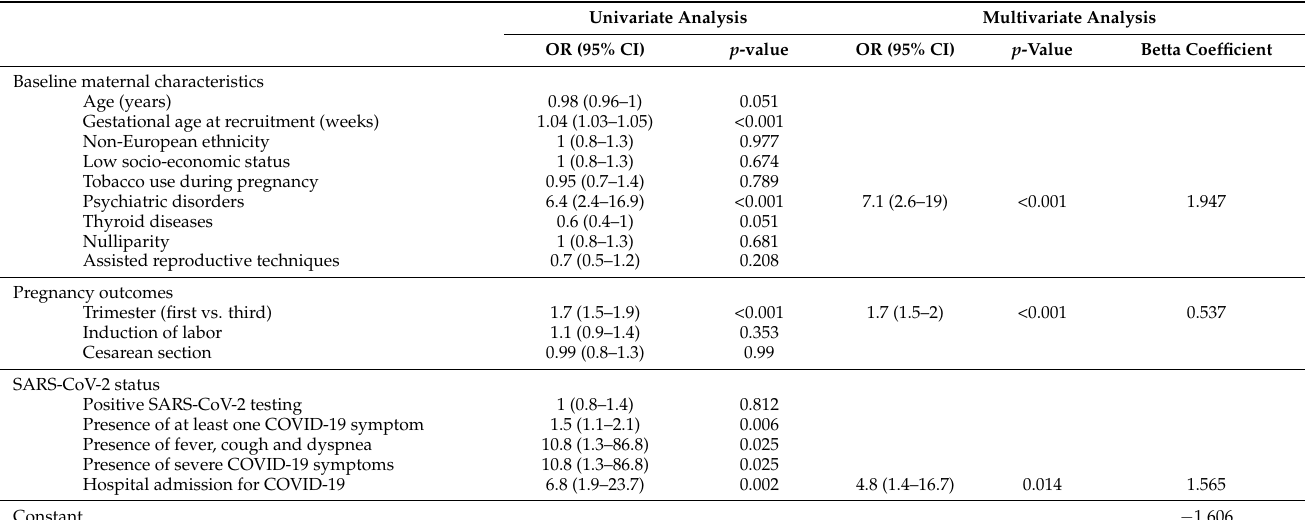
Table 6. Multivariate analysis of factors associated to poor maternal WHO-5 well-being in the pandemic